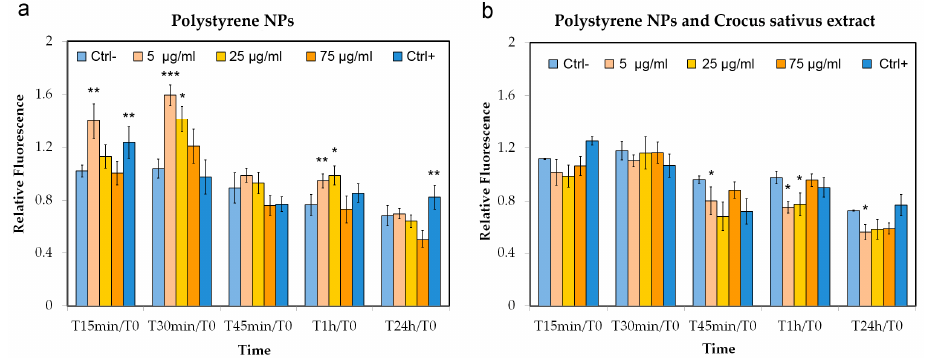
Figure 5. ROS detection in Hs27 cells: the effects of polystyrene nanoparticles (PNPs) on ROS production were evaluated following exposure at 0, 15, 30, 45, 60 min, and after 24 h at 5, 25, and 75 μ g/mL concentrations. Each time refers to T0. Hs27 ROS production with PNPs ( a ) and Hs27 ROS production added with antioxidant stigma extract of Crocus sativus (25 μ g/mL) ( b ). H 2 O 2 (150 μ M) was used as a positive control. Significance values * = p < 0.05; ** = p < 0.005; *** = p < 0.0005; error bars represent the standard error of the mean. Table 1. ROS detection comparison in Hs27 cells treated with polystyrene nanoparticles (PNPs) and PNPs added with the Crocus sativus stigmas extract. Values are means ± SD. 5 µg/mL P Value Time Ratio